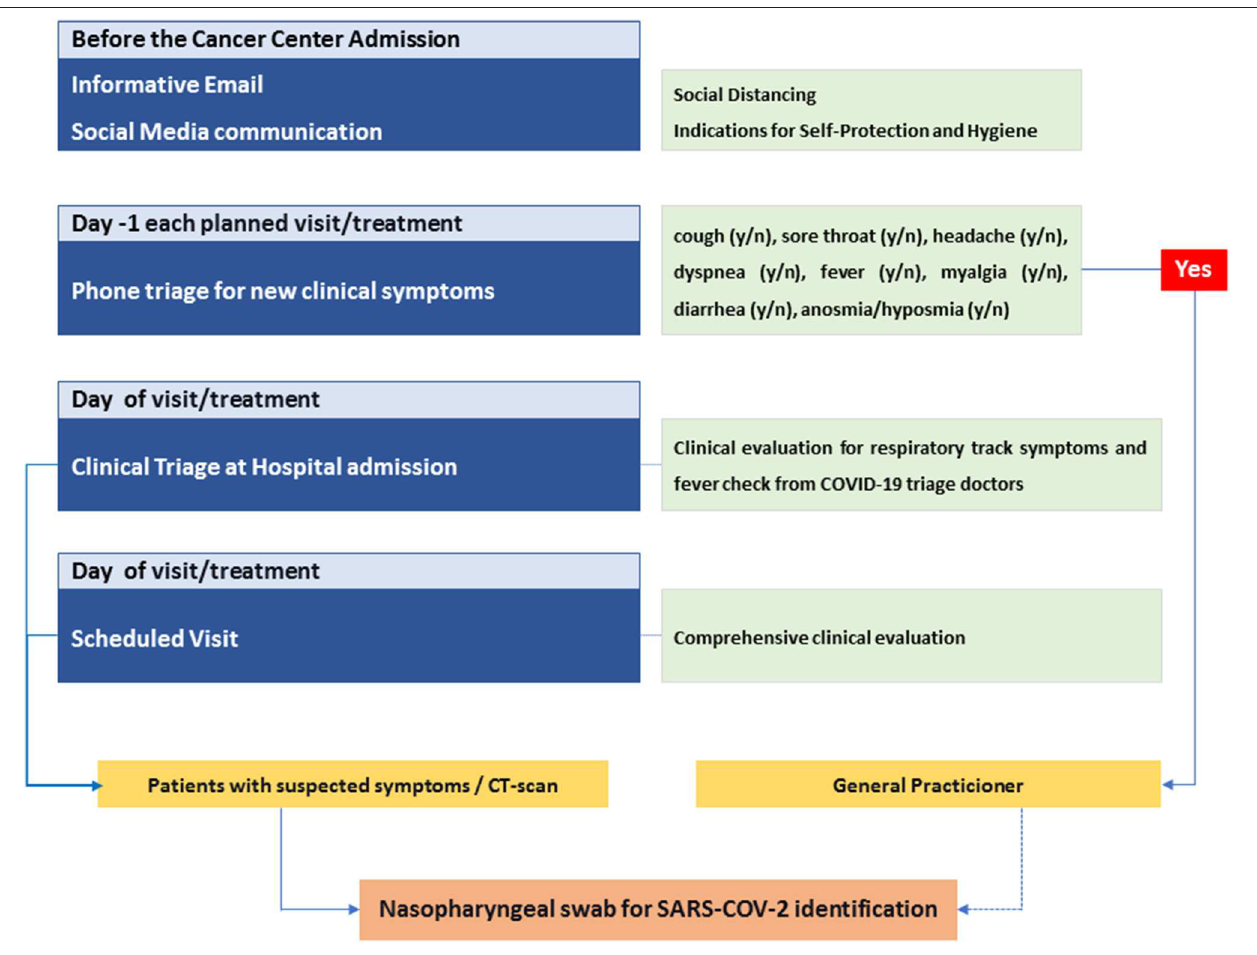
FIGURE 1 | Flow chart of applied multilevel containment